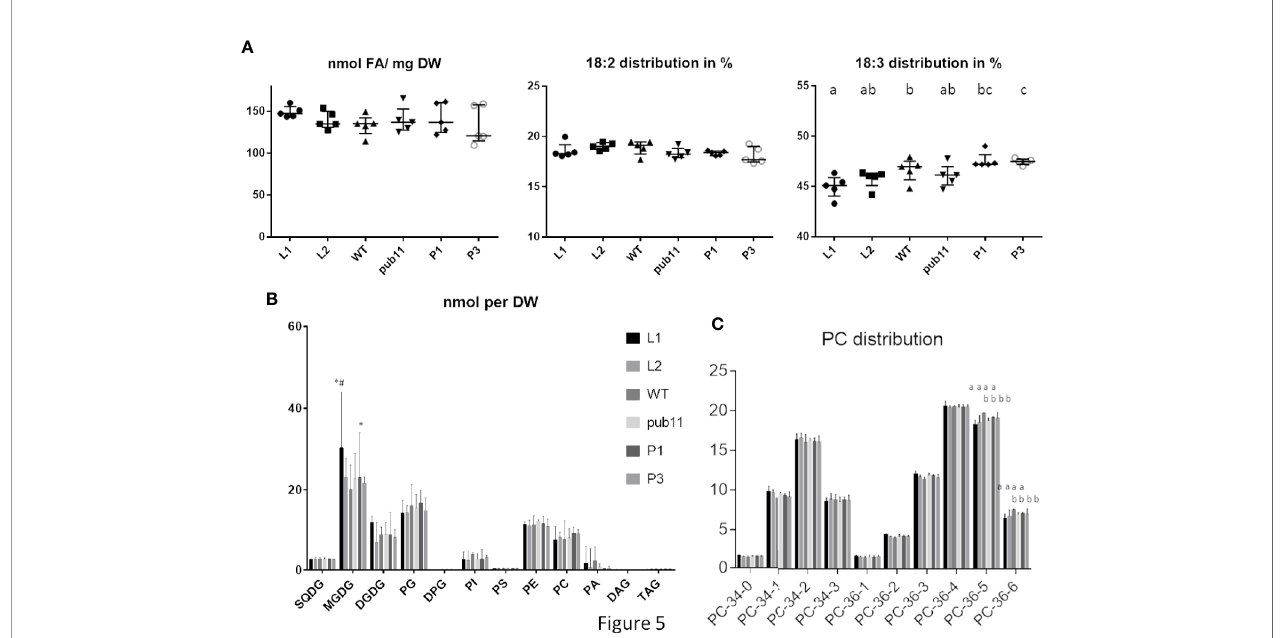
FIGURE 5 | Lipid composition of aerial part of 15 d old plantlets of pub11 lines overexpressing ALA10-GFP. (A) Fatty acid content and distribution of 18:2 and 18:3 fatty acids. (n = 5, Unpaired t test with Welch ’ s correction, P <0.05, differences between means that share a letter are not statistically signi fi cant). (B) Glycerolipid content. Glycerolipids were analyzed by MS and all glycerolipid data are expressed in nmol as adjusted to a standard reference of Arabidopsis leaf lipid extract run in parallel. All contents are expressed per dry weight. Lines which are compared are WT, pub11 and overexpressors of ALA10-GFP in WT (L1 and L2) and in pub11 (P1 and P3). Lipid are analyzed by MS (Jouhet et al., 2017). N = 5. * and # indicate statistically signi fi cant differences (Student ’ s t test with Welch ’ s correction, P <0.05) with WT (*) and pub11 (#). (C) Relative distribution of the main molecular species of PC. (n = 5, two way ANOVA corrected for multiple comparison for C, P <0.05, differences between means that share a letter are not statistically signi fi